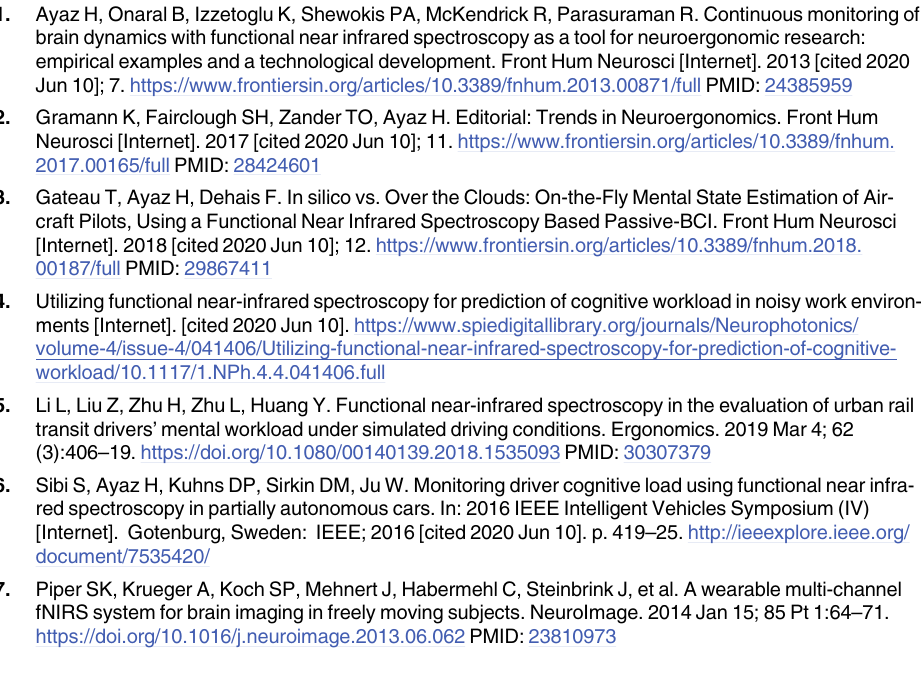
S1 Fig. Δ HbO time series during each motor task in each fNIRS system. Δ HbO timeseries (95% confidence ribbons) plotted at all measurement locations within each system (facet rows) and for each task (facet columns). Plots at each location are scaled to have common axes, the grey band marks the task period, and the black line marks the mean of the 5 seconds preceding the task. (TIFF) S1 Table. Tabulated mean/standard error values (across participants) for all combination of measurement location, task, and fNIRS